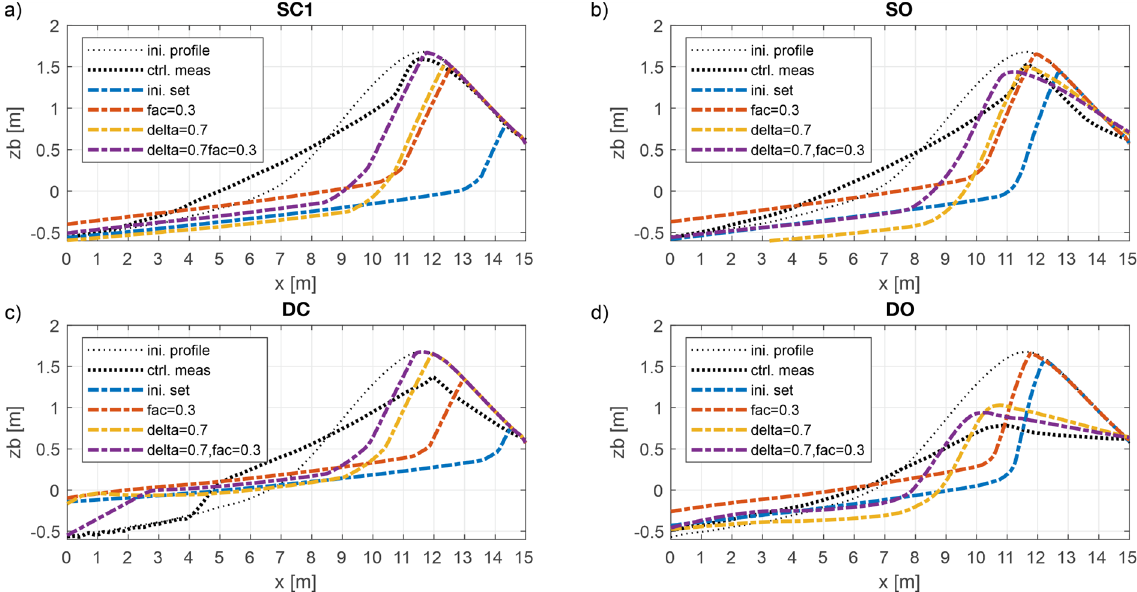
Figure 4. Morphodynamic calibration: Comparison between final measured (dashed) and simulated (dash-dotted) dune profiles for hydrodynamic conditions SC1 ( a ), SO ( b ), DC ( c ) and DO ( d ). The control cases were used as the initial input (dotted).